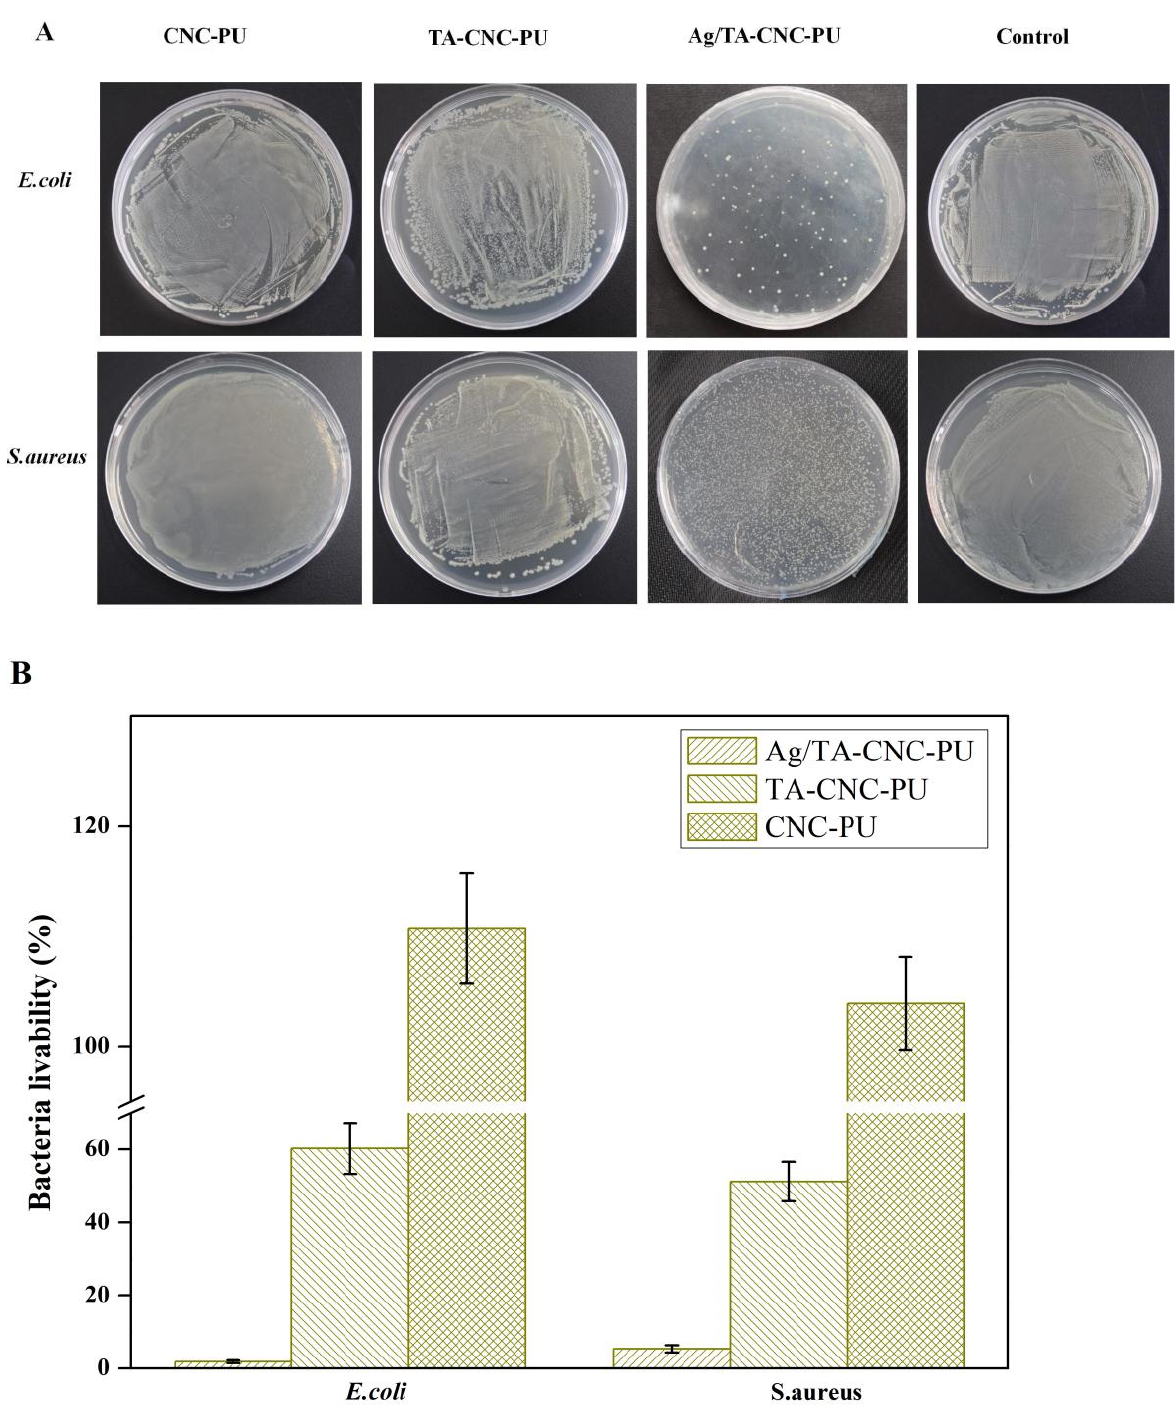
Figure 8. Inhibition of CNCs-based PUs against E. coli and S. aureus . ( A ) Colony growth, ( B ) bacteria liv ability.